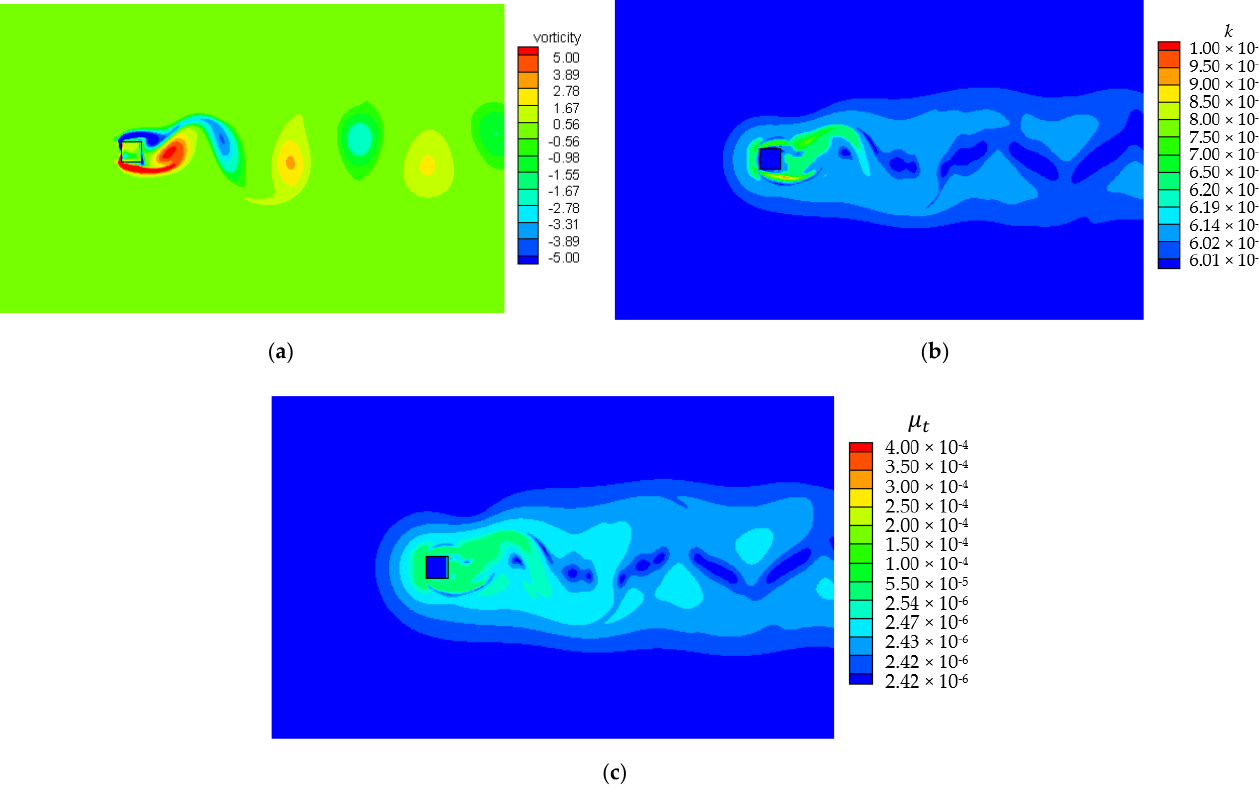
Figure 3. Contours of vorticity, turbulent kinetic energy, and turbulent dissipation. ( a ) Vorticity; ( b ) turbulent kinetic energy; ( c ) turbulent dissipation rate.